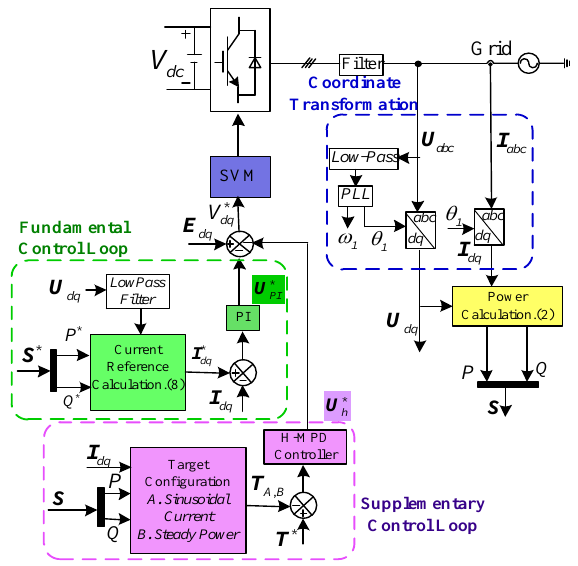
Figure 2. The proposed control strategy with flexible control targets.